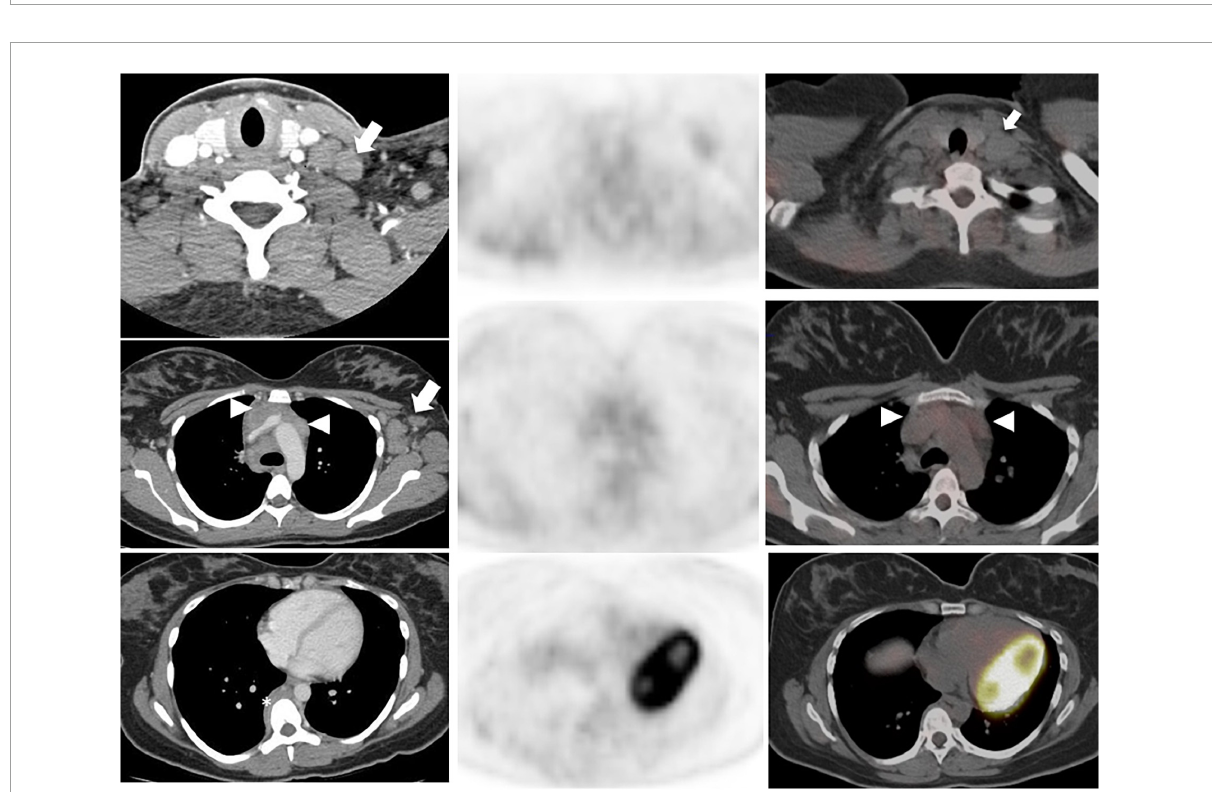
FIGURE2 A 28-year-old woman with Stage IIB nodular sclerosing Hodgkin’s lymphoma. Baseline staging with contrast-enhanced CT (left column) showed multiple lymphadenopathies in the left neck, supraclavicular fossa (arrow, top row) and axilla (arrow, middle row) , an infiltrative soft tissue mass in the anterior mediastinum (white arrowhead, middle row) , and a paravertebral soft tissue lesion in the mid thoracic spine (asterisk, bottom column) . Interim 18 F-FDG PET/CT (PET, middle column ; fused PET/CT, right column ) after 2 cycles of chemotherapy demonstrated complete metabolic response and significant morphologic response ( right column fused PET/CT images); overall Deauville score, 2. A negative interim PET can support the decision to de-escalate therapy; whereas a positive PET may indicate need for therapy